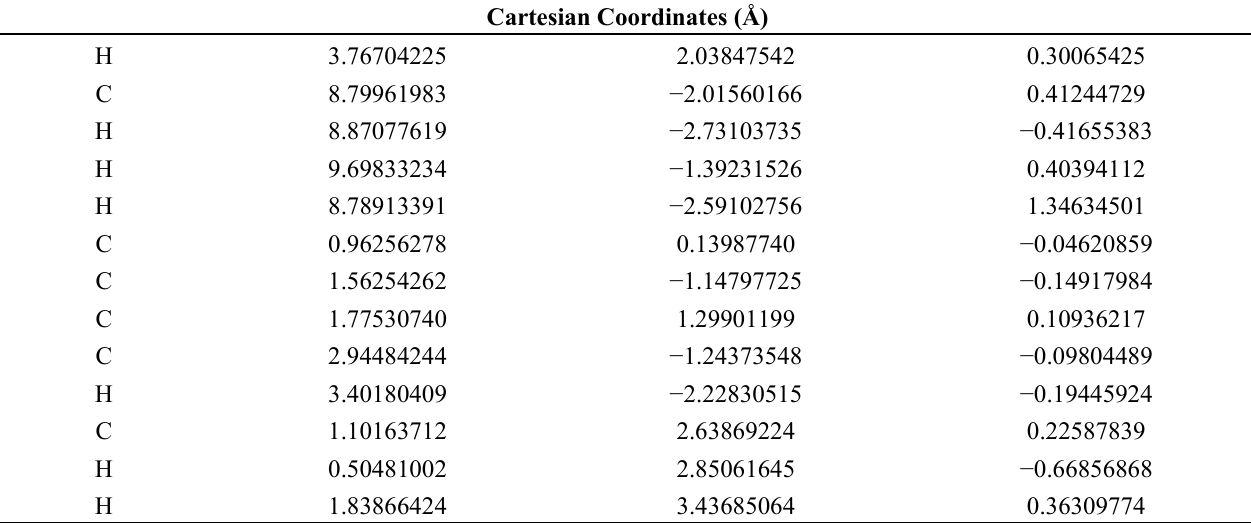
Table A1. Cartesian Coordinates (Å) of 1-L4 Optimized at the TPSS-D3/def2-TZVP Level of